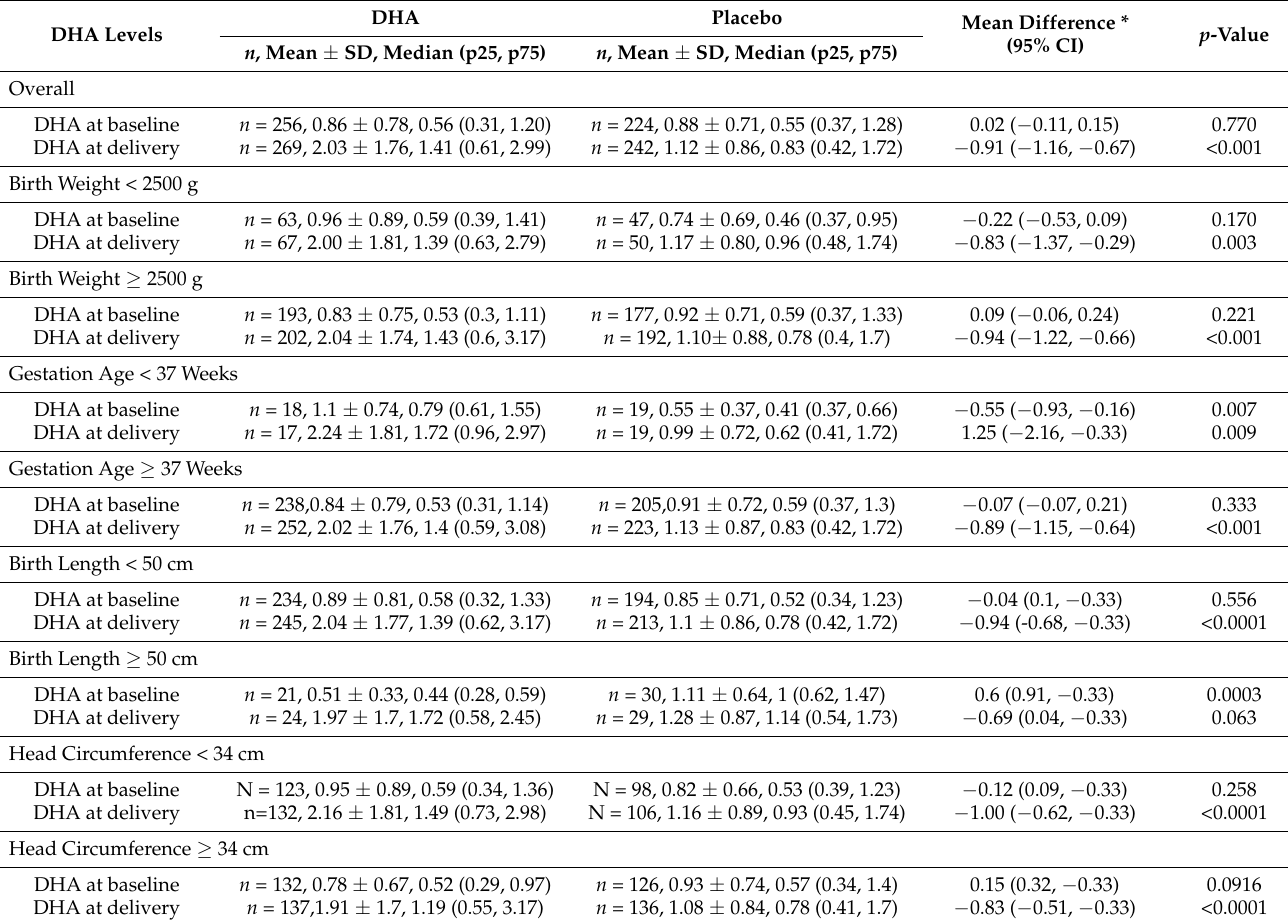
Table 2. Mean DHA (mol% of fatty acid) levels in RBC